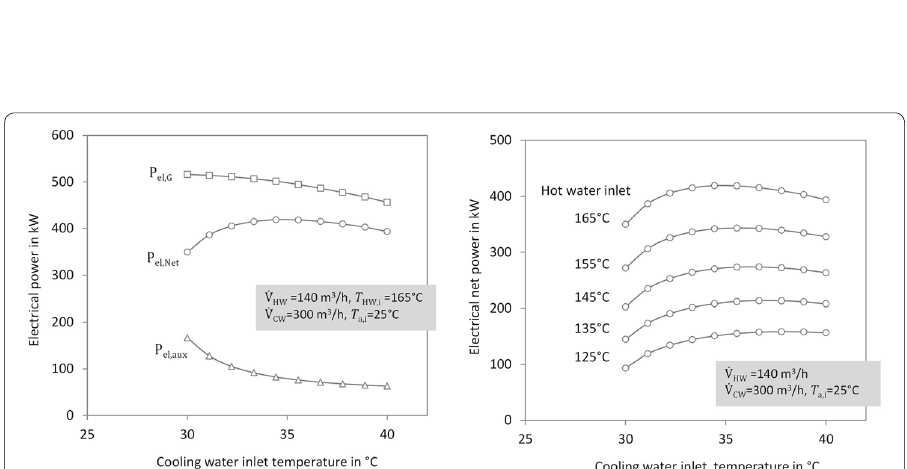
Fig. 15 Estimated generator power, net power and auxiliary power (left) and net power for different hot water inlet temperatures (right) depending on the cooling water temperature